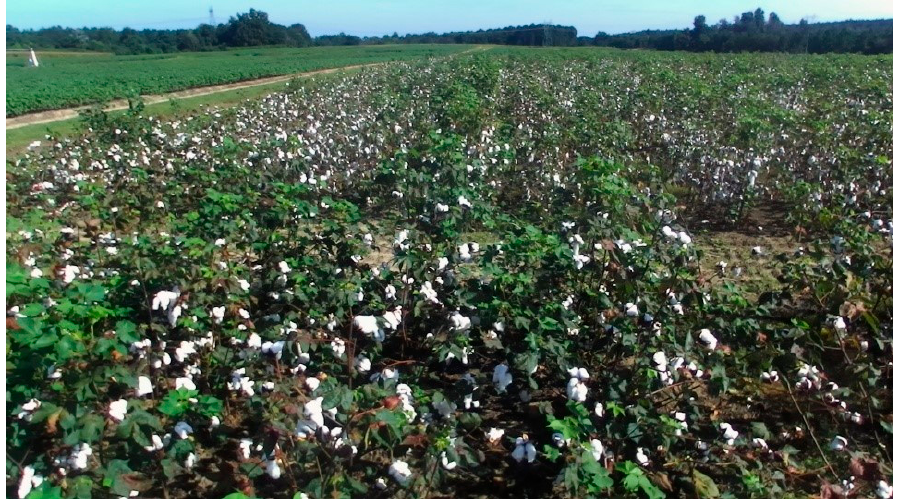
Figure 5. The undefoliated cotton field at UGA farms.